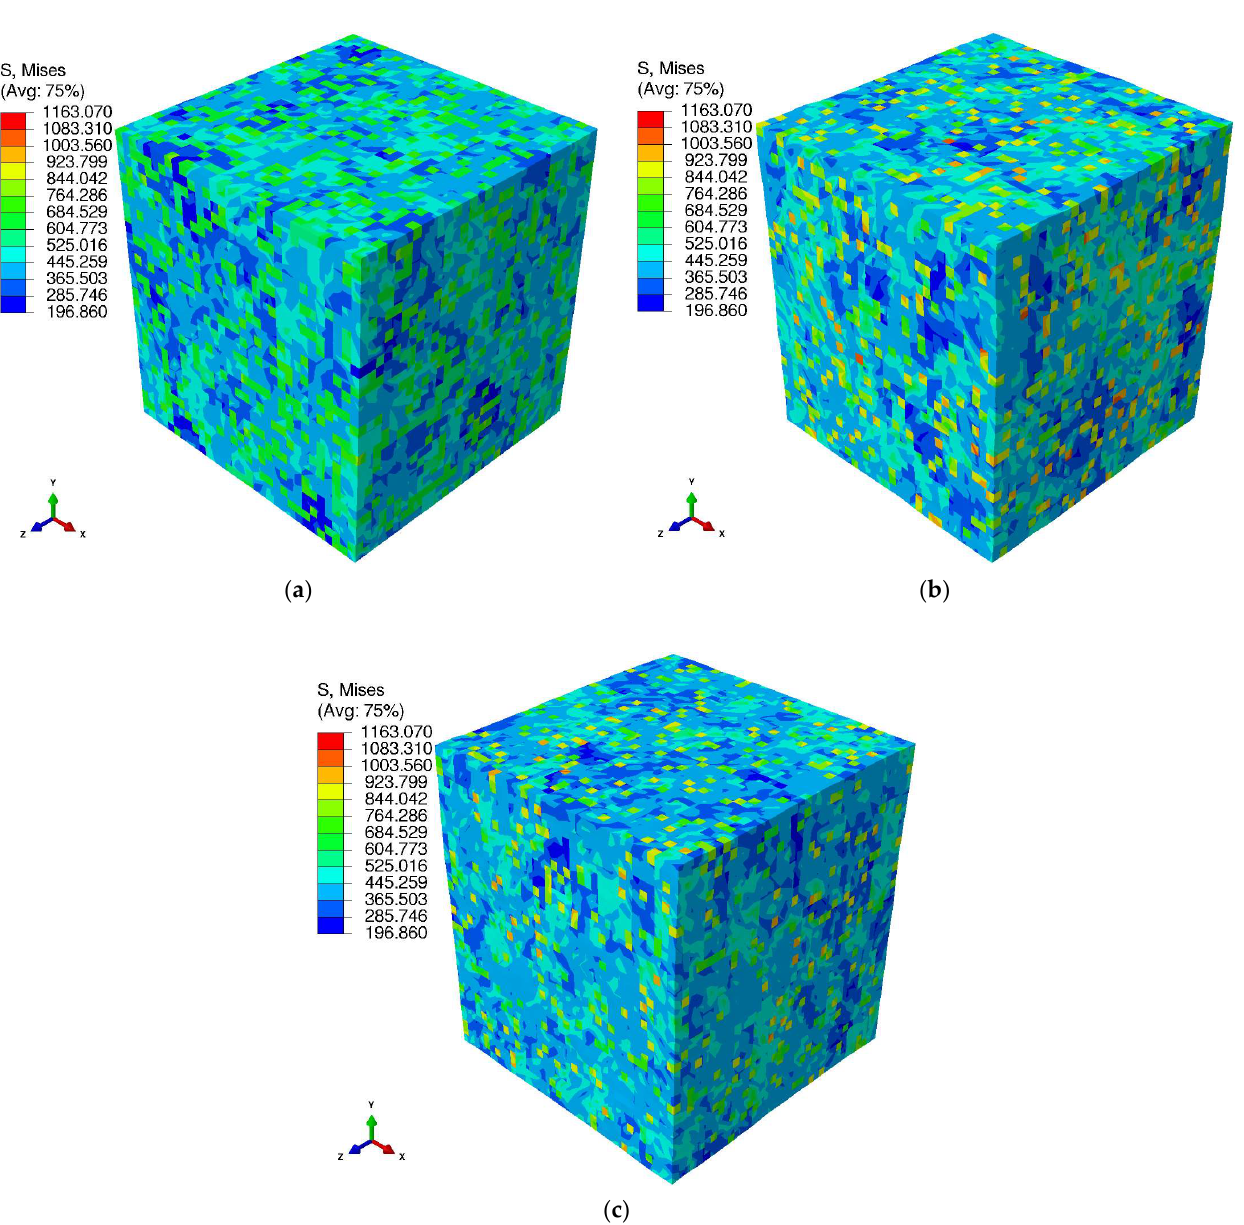
Figure 13. Microscopic stress field obtained using the CP model for the PBF-LB/M AlSi10Mg AB and HT states. ( a ) Stress distribution in the AB state at the applied strain of 4.25%, ( b ) stresses for the HT1 state at the applied strain of 10%, and ( c ) stresses for the HT2 state at the applied strain of 8%.